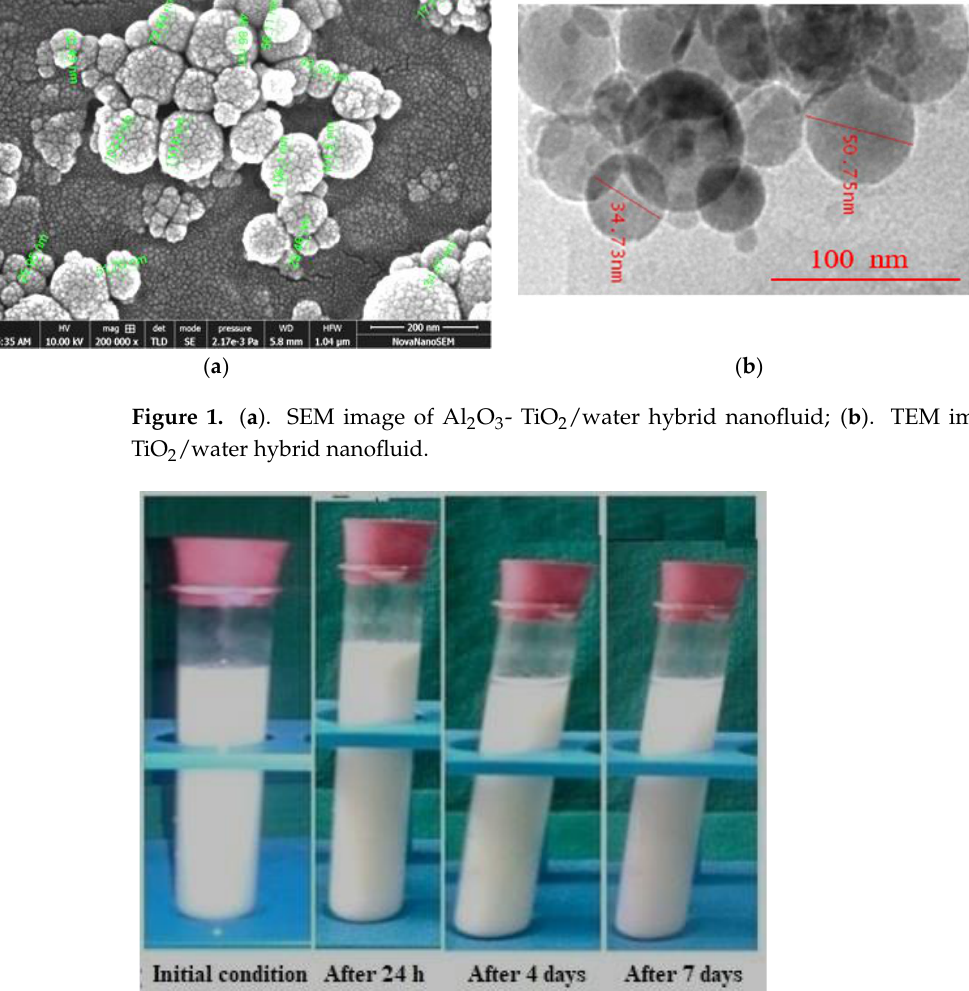
Figure 2. Stability analysis of a sample showing no sedimentation for 7 days.